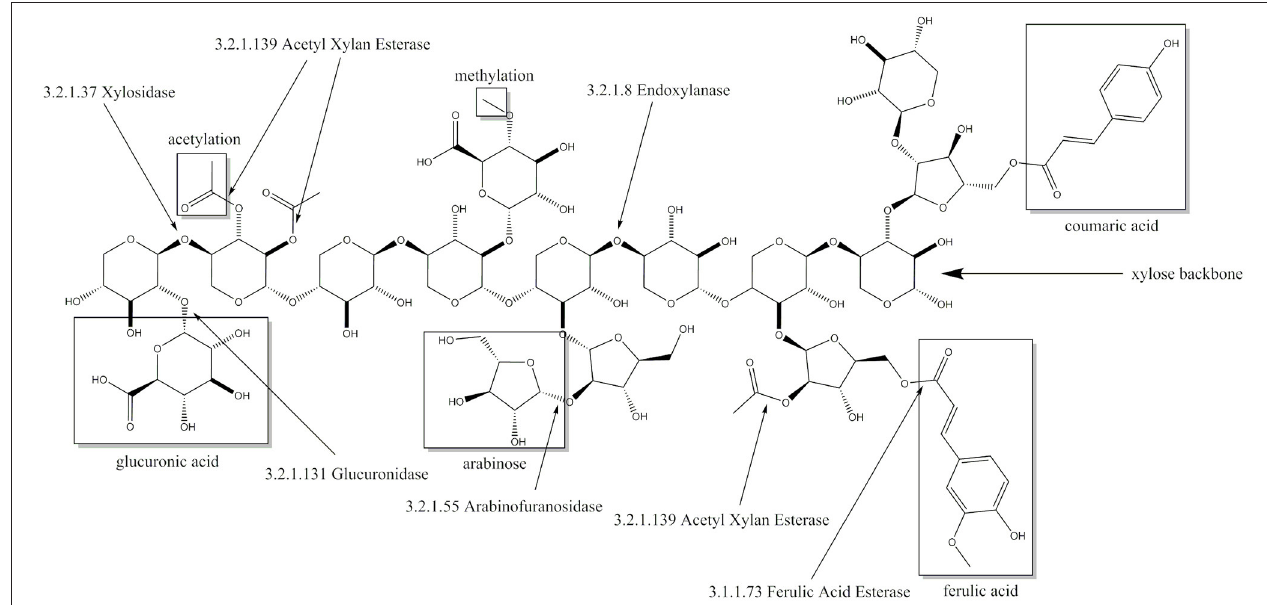
FIGURE 1 | Xylose backbone of xylan with possible substitutions and the cleaving sites of corresponding enzymes including enzyme commission number.